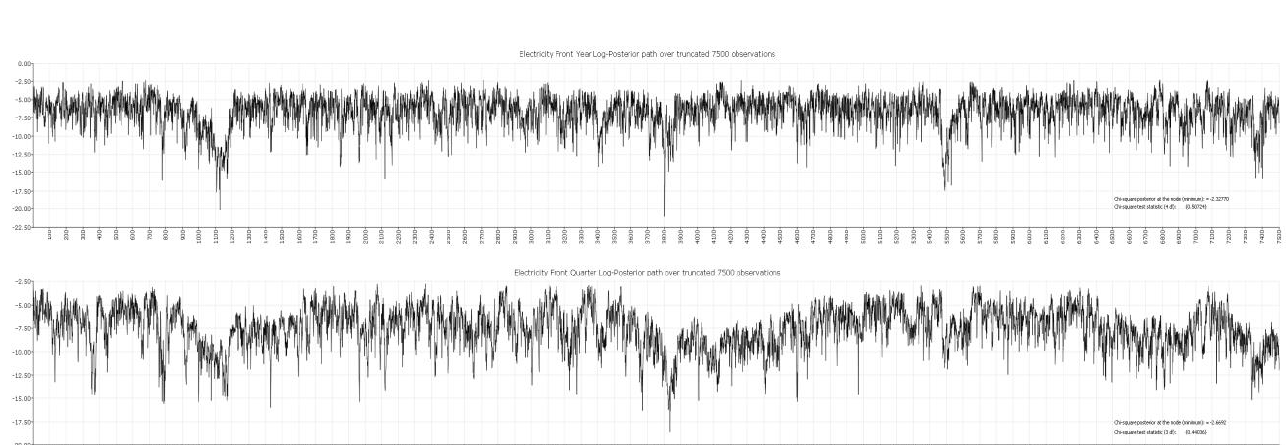
Figure 2. MCMC Posterior Chain from 250 k Optimal SV Model (R =